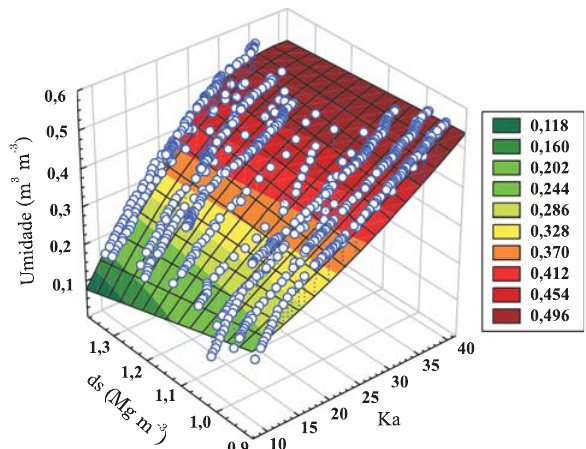
Figura 4. Valores medidos experimentalmente de θθθθθ em função de Ka em diferentes valores de Ds. A superfície apresentada corresponde ao